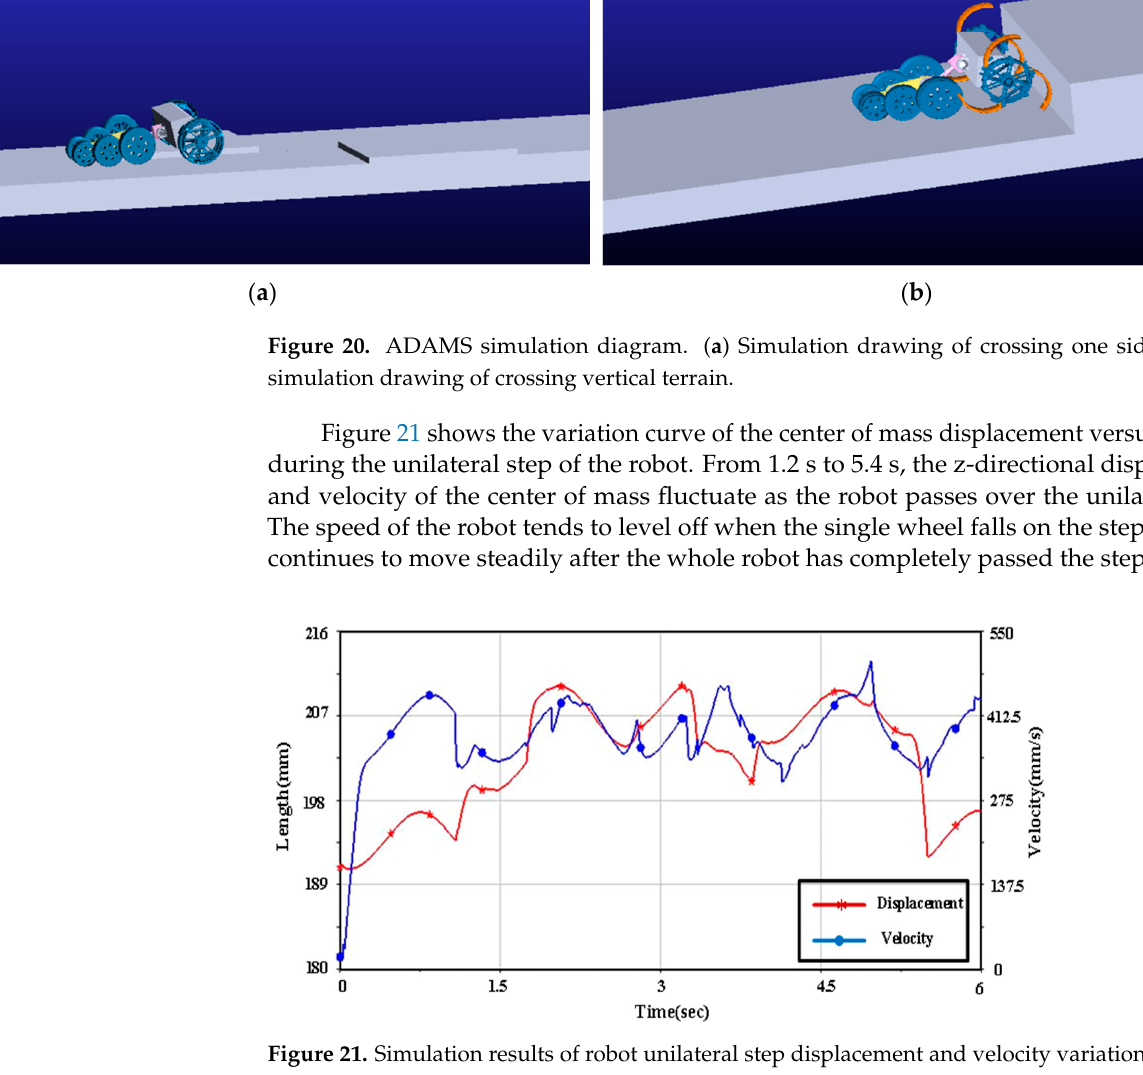
Figure 22. Simulation results of robot vertical terrain displacement and acceleration variation. 6. Specification and Conclusions Based on the wheel-legged transformable mechanism and the control system, this robot can adapt to the working environment by changing the diameter and morphology of the wheel-legs. The essential parameters of the robot are summarized in Table 2.